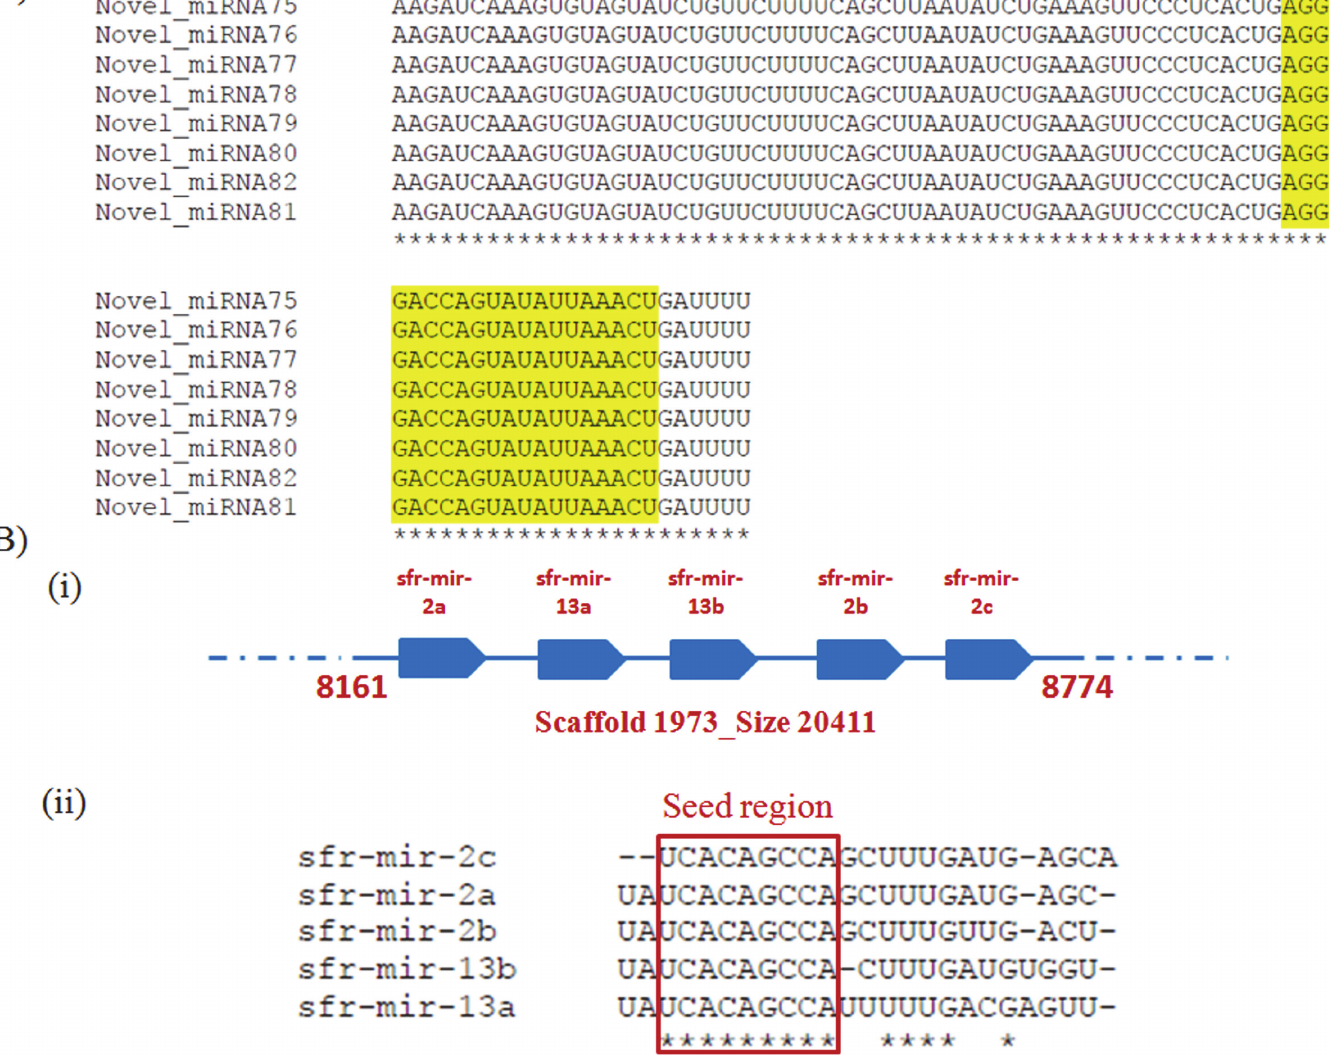
Fig 3. Analysis of novel miRNAs identified in the library. (A) Similarity between the precursor sequences of a miRNA family identified in the population. (B) (i) The largest miRNA cluster identified from the library using Sf draft genome assembly as a reference. (ii) Similarity in the nucleotide composition of the mature miRNA sequences present in the cluster, especially the seed